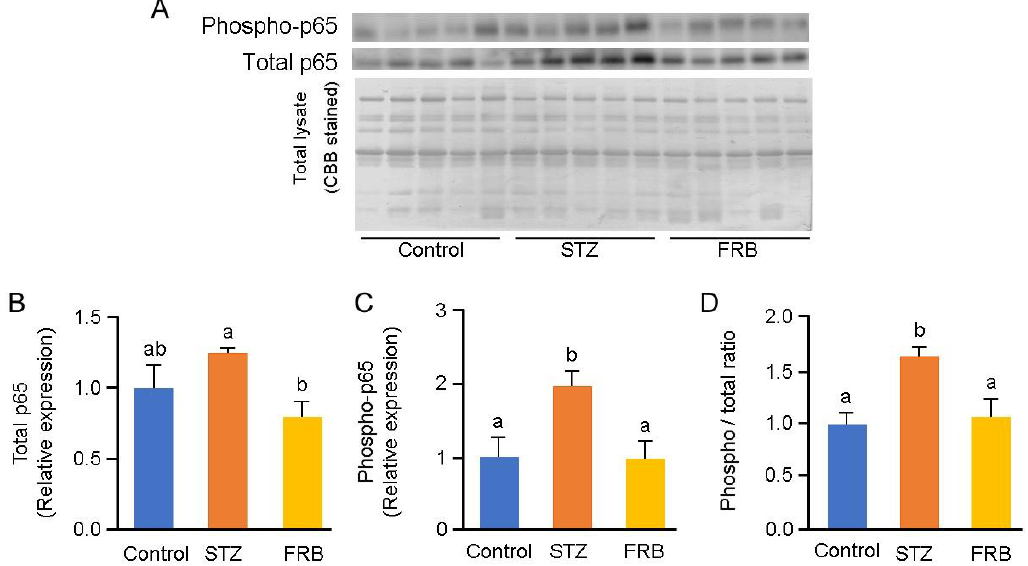
Figure 8. FRB inhibits NF- κ B activation. Representative blots of ( A ) phosphorylated p65 (phospho-p65) and total p65, and the quantification of ( B ) total p65, ( C ) phospho-p65, and ( D ) phospho-p65 / p65 ratio. Data are shown as the means + SEM. Significance ( p < 0.05, n = 5) among groups is denoted by different letters (a, b, ab).